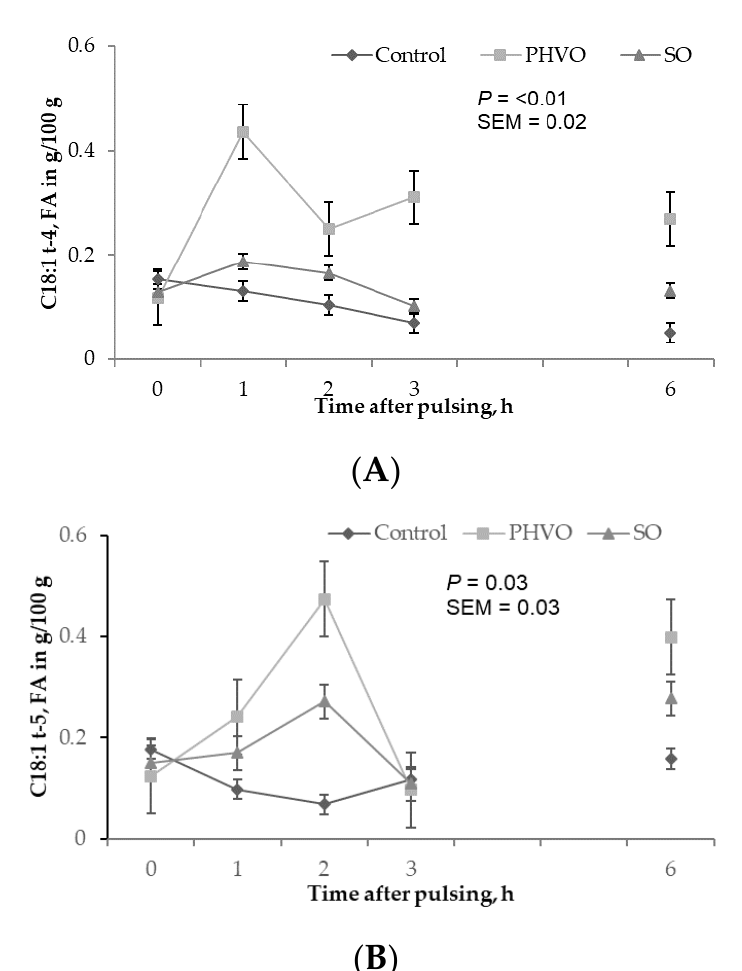
Figure 2. Day variations of C18:1 trans fatty acids (FAs) in ( A ) total plasma; ( B ) high ‐ density lipo ‐ protein (HDL) and ( C ) low ‐ density lipoprotein (LDL) fractions from cows subjected to ruminal pulses of control, partially hydrogenated vegetable oil and soybean oil. SEM = standard error of the mean. a,b,c Means with different superscripts differ significantly ( p < 0.05). Pooled means of control, partially hydrogenated vegetable oil and soybean oil per day are shown. p ‐ value repre ‐ sents the effect of sampling